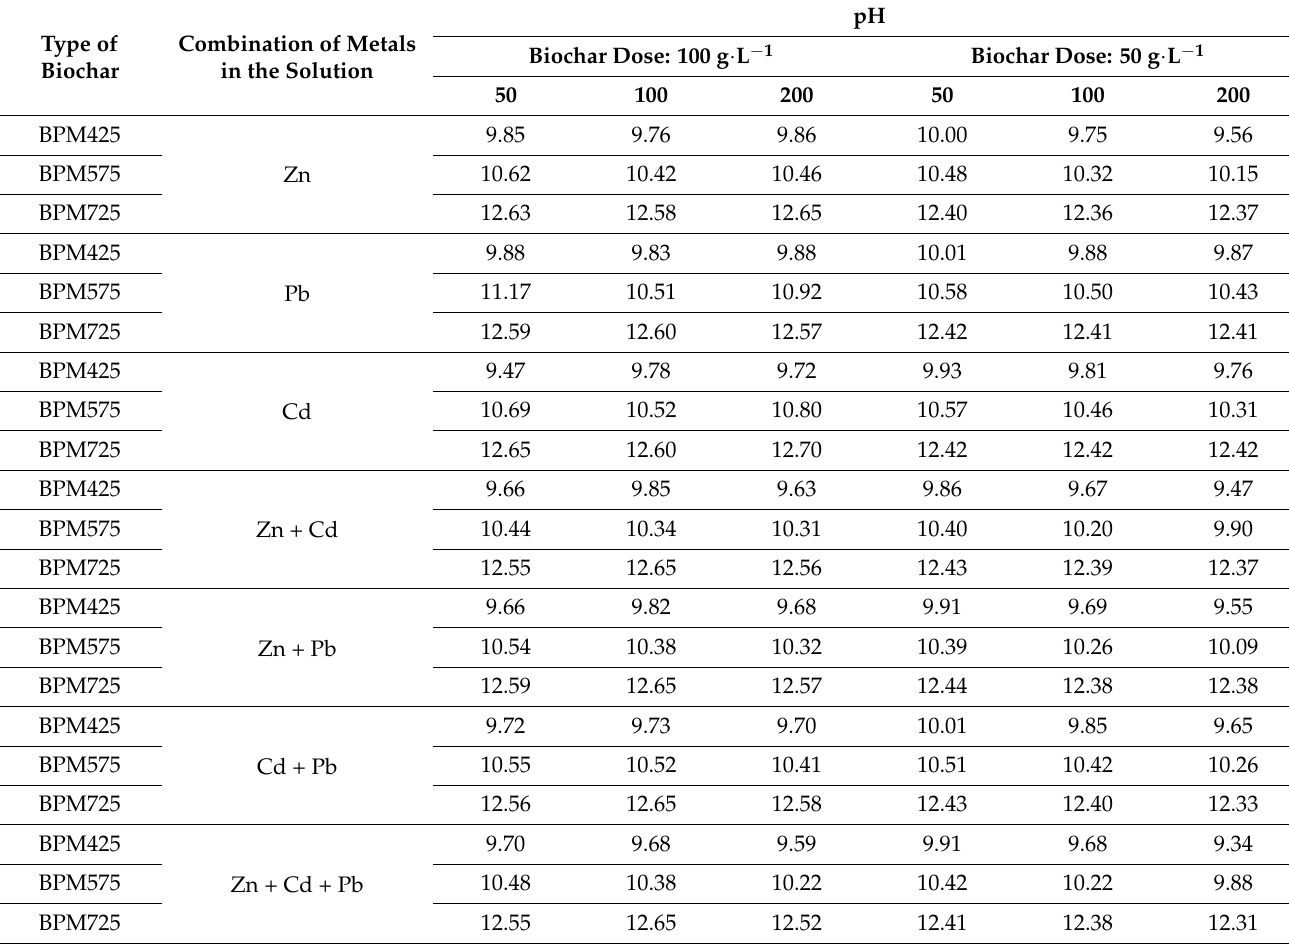
Table 15. The pH values after the completion of sorption from the solutions containing mono-, double- or triple-metal